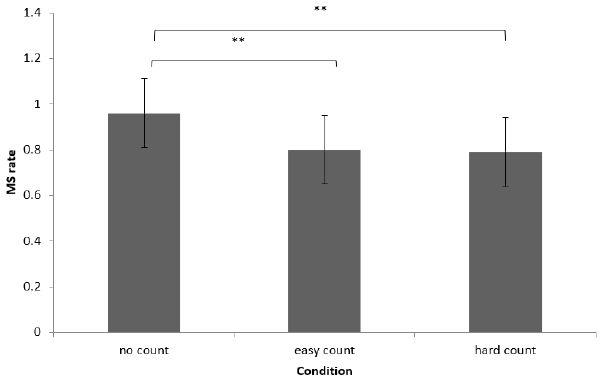
Figure 6 . Microsaccade rate decreased as task difficulty increased in the mental workload task. In the no count condition microsaccade rate was significantly higher than in the easy count or hard count